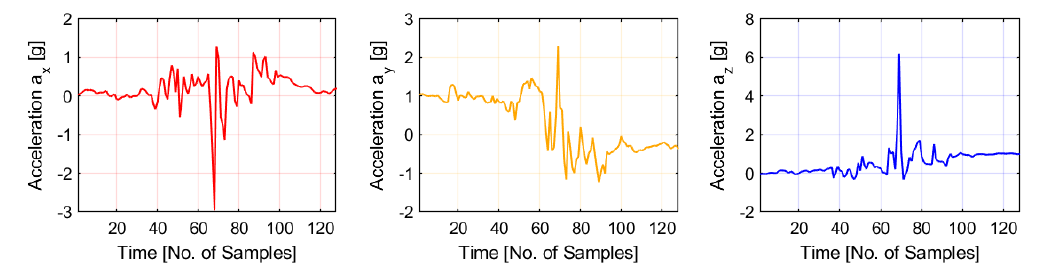
Figure 2. Three axes accelerometer signals a x , a y and a z for